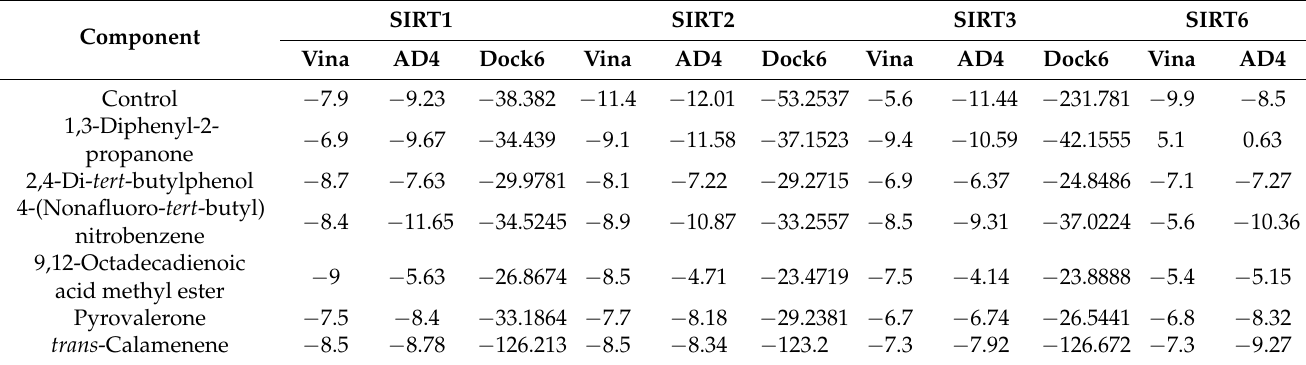
Table 4. In silico docking simulation of active volatile components of fermented soybean CGJ with SIRTs.